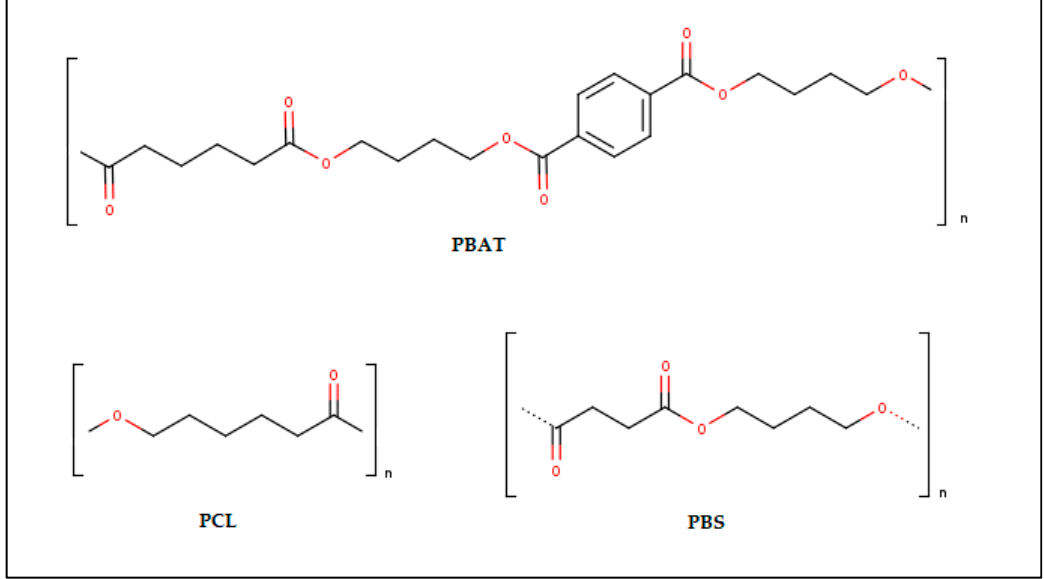
Figure 10. The chemical structures of fossil fuel based biodegradable polymers